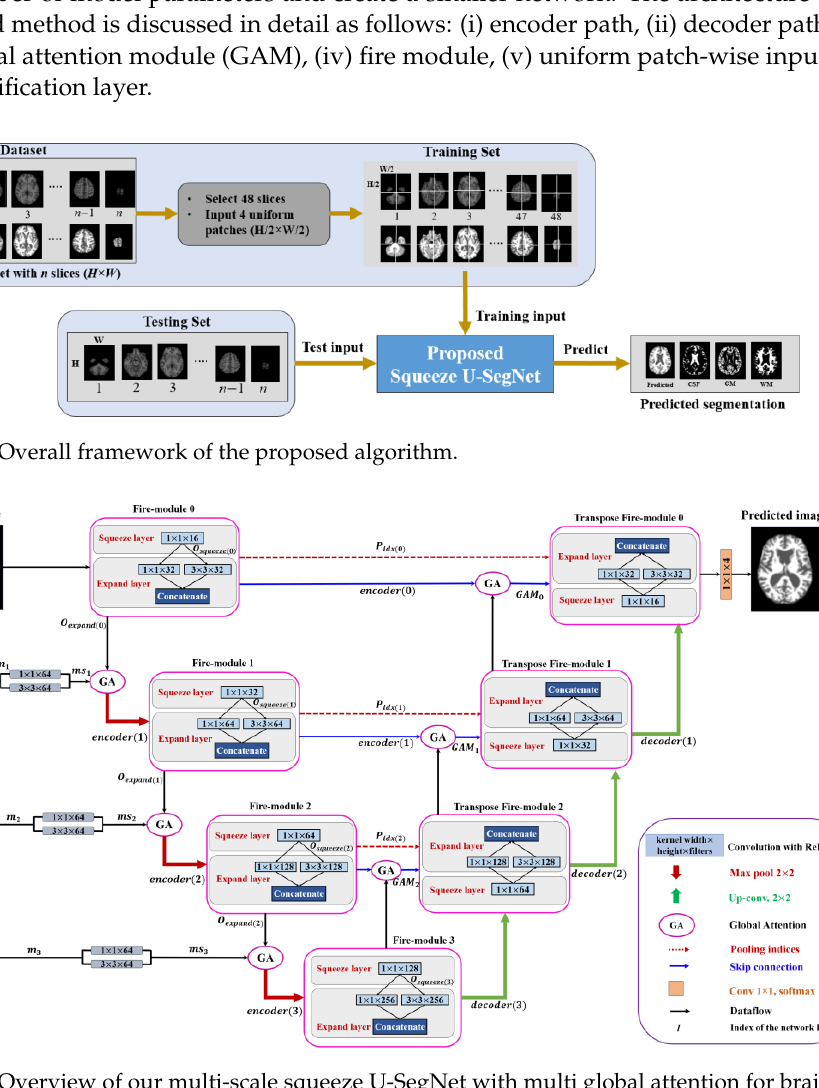
Figure 2. Overview of our multi-scale squeeze U-SegNet with multi global attention for brain MRI segmentation. Solid blue boxes represent the convolution block with dimensions as kernel width × height × filters followed by ReLU activations.